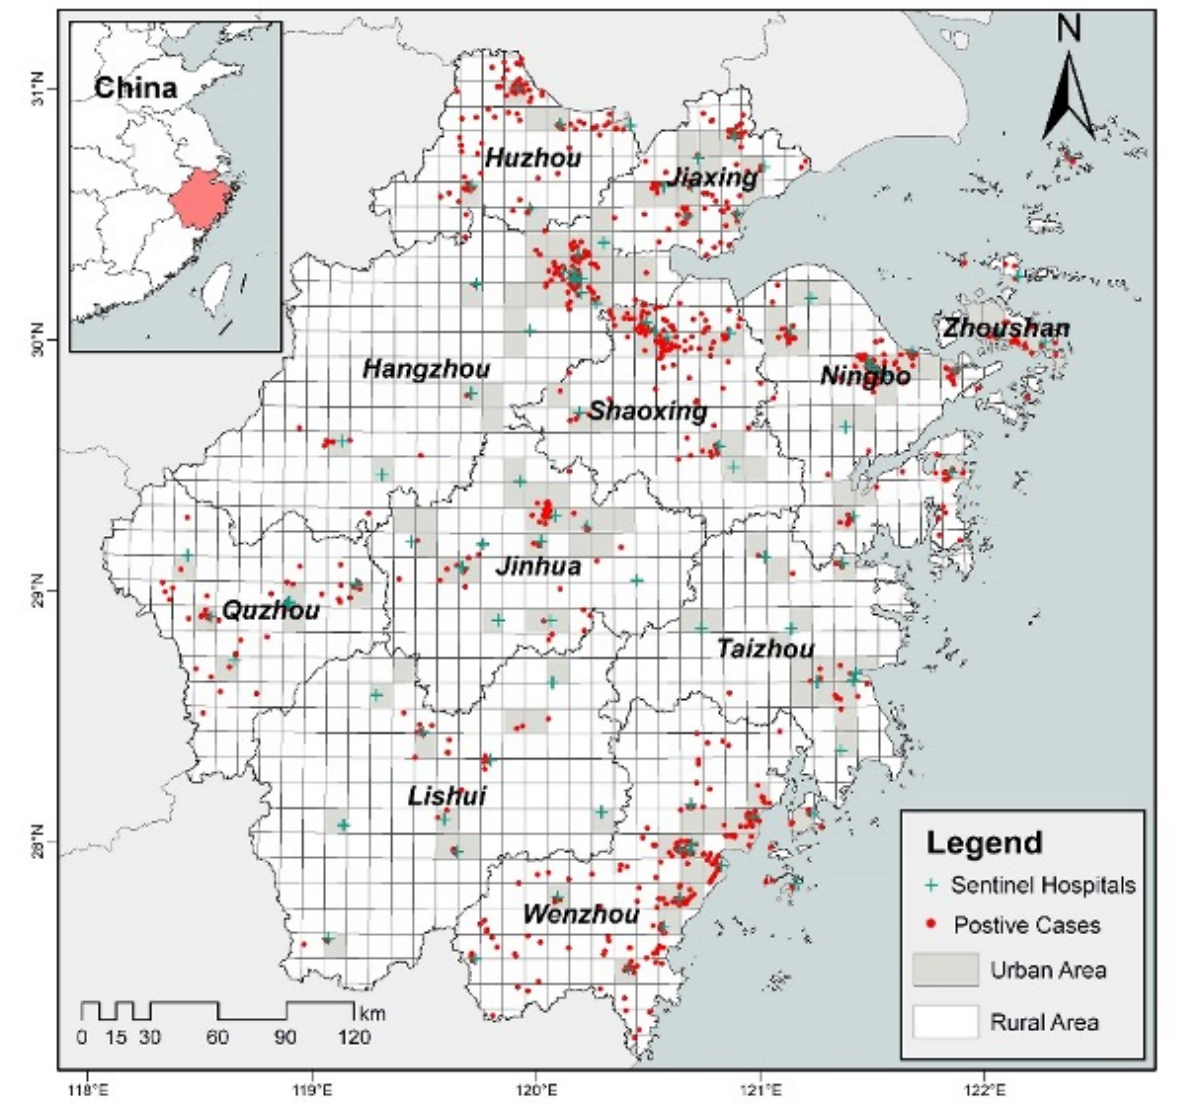
Figure 1. Locations of the study area (0.1° × 0.1° grid size) and positive cases caused by V. parahaemolyticus .